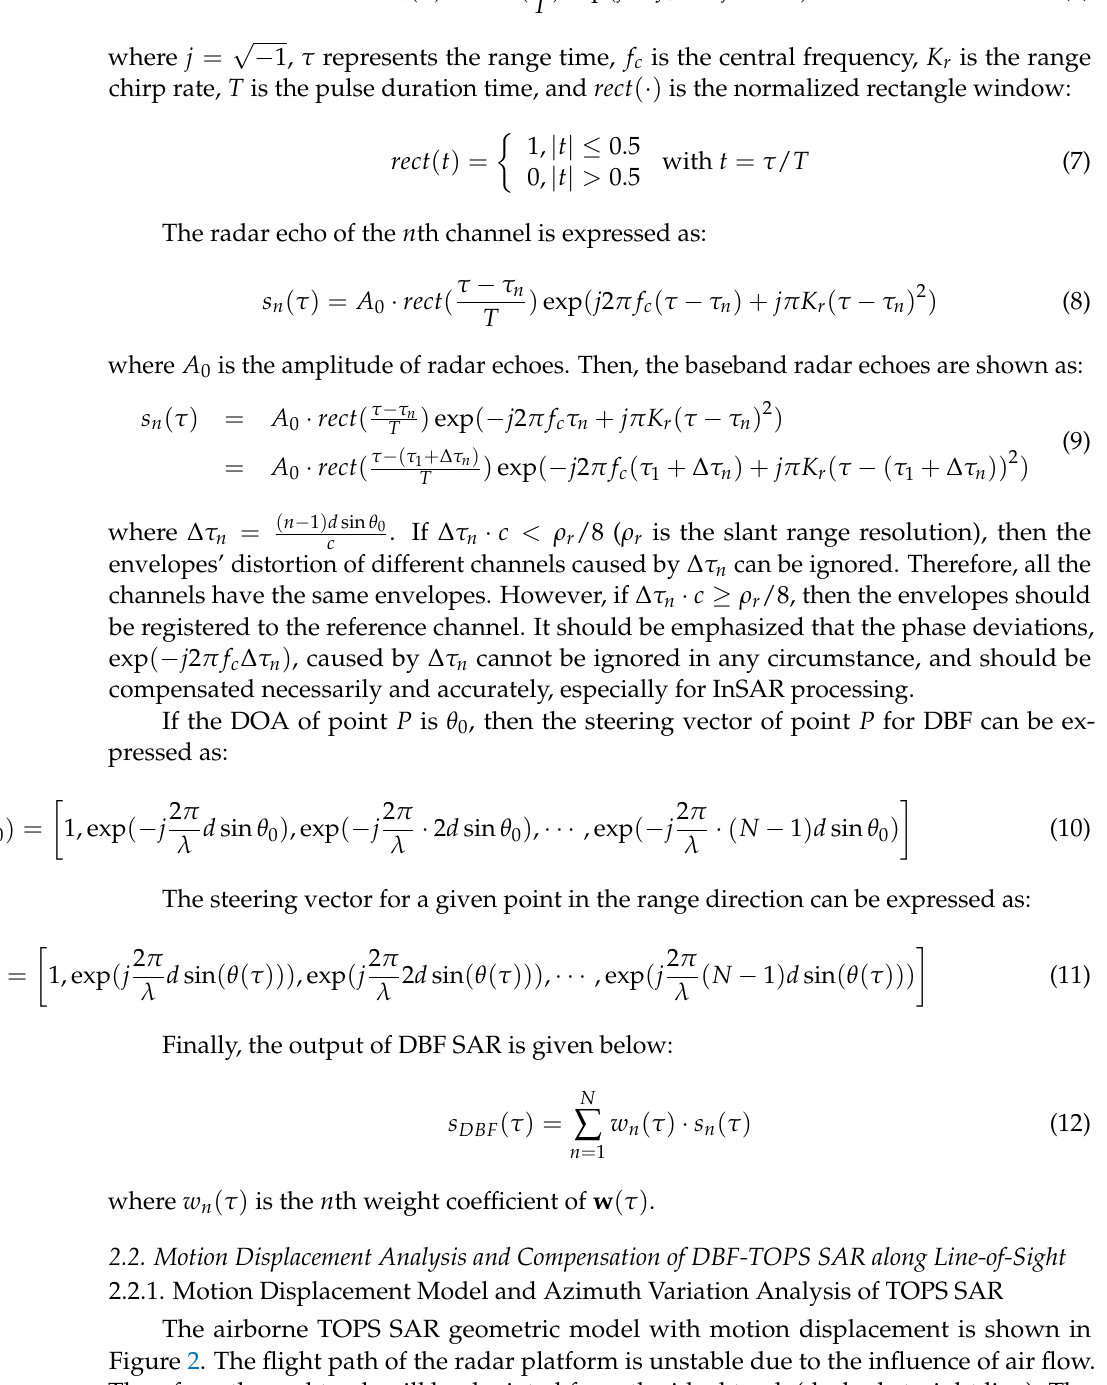
Therefore, the real track will be deviated from the ideal track (dashed straight line). The beam center line is steered to point P